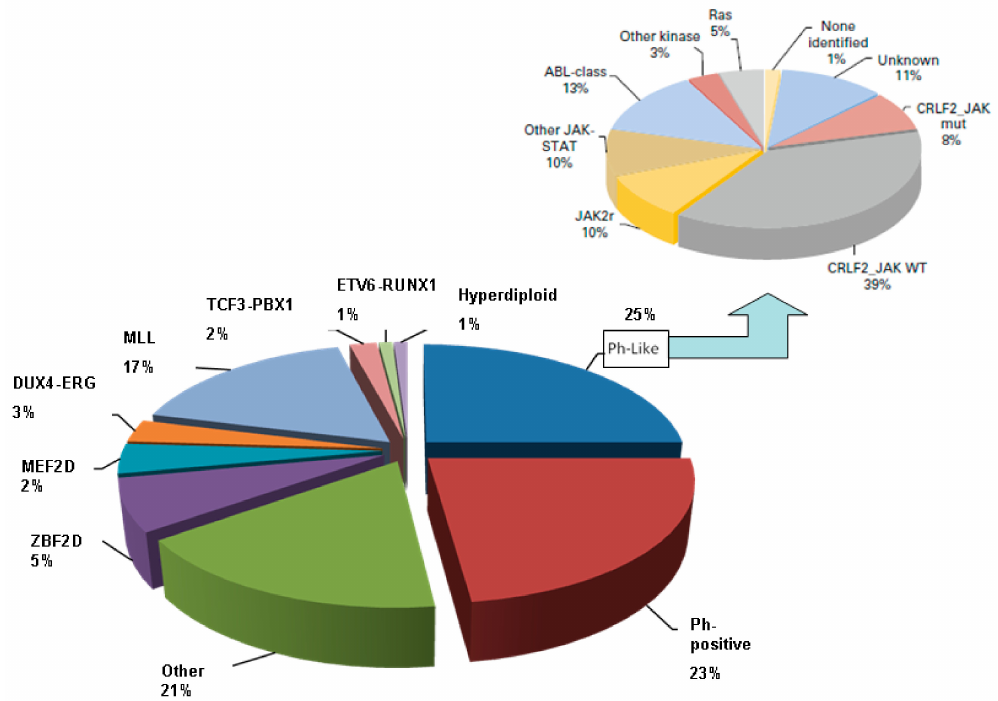
Figure 1. Genetic landscape of adult B-cell acute lymphoblastic